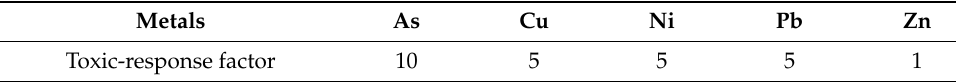
Table 2. Toxic-response factor values of toxic metals by Hakanson